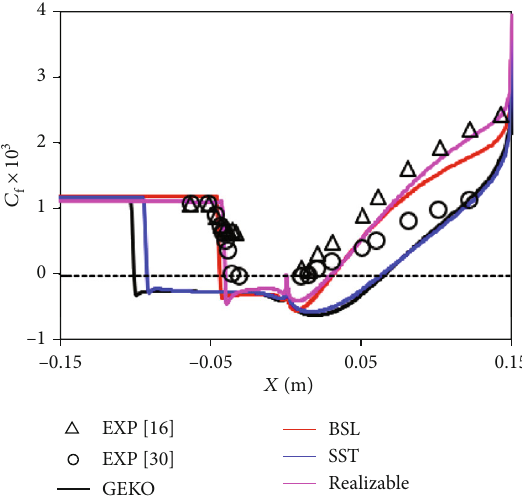
Figure 10: Skin friction coe ffi cient distribution along the bottom surface.